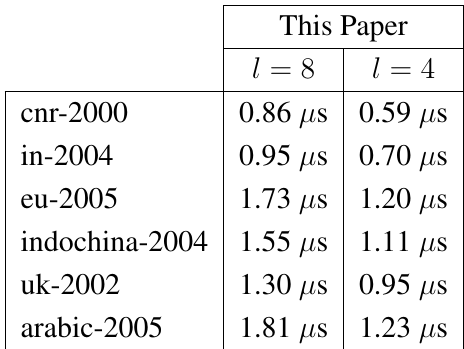
Table 10. Average times to test adjacency between pairs of random